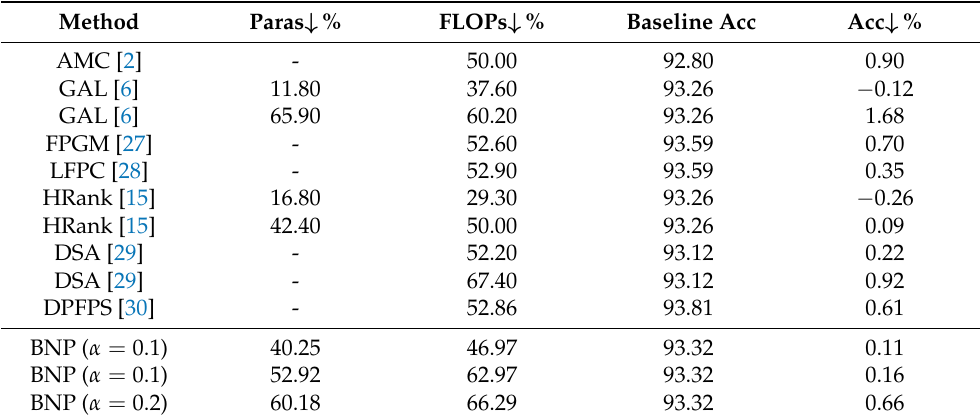
Table 2. Network pruning results of ResNet-56 on CIFAR-10.